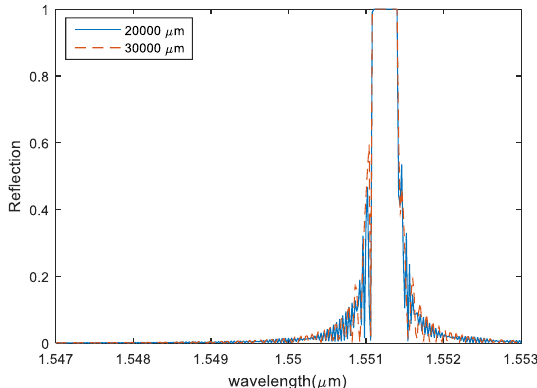
Figure 8: Reflection response in FBG with different grating length under 1000 micro